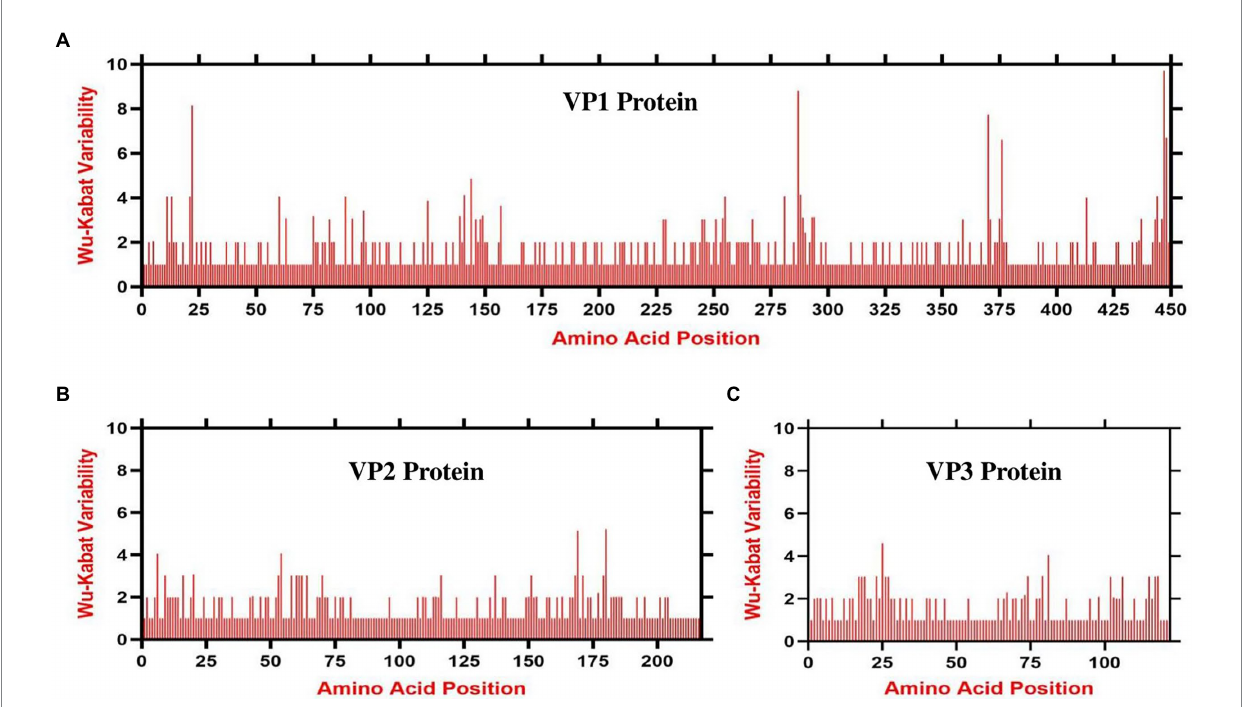
FIGURE 5 Amino acid variability landscape of full-length proteins of CAV, 1991–2020. The plot represents amino acid variations in (A) ORF1-encoded VP1 capsid protein, (B) ORF2-encoded VP2 protein and (C) ORF3-encoded VP3 apoptin protein. The ORFs nucleotide sequences were used to acquire their consensus amino acids sequence using the Wu-Kabat variability coefficient implemented by PVS. Y-axes represent the Wu-Kabat variability coefficient values, where the estimation limit is 1. Above the limit of 1 represents variations. X-axes represent the amino acid